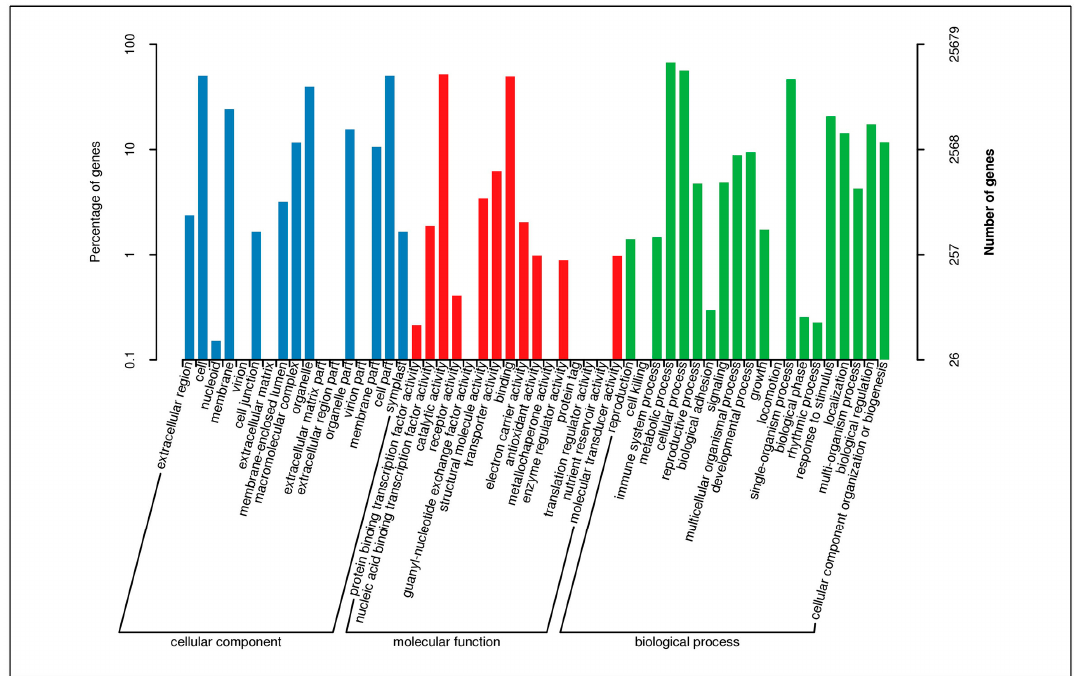
Figure 5. GO Classification of all unigenes.